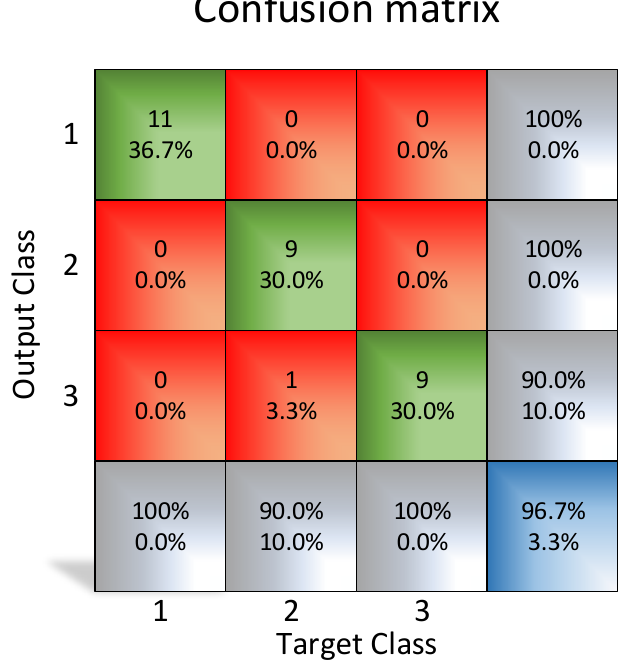
Figure 14. Matrix of the obtained results using MATLAB (16 × 16 pixels resolution).